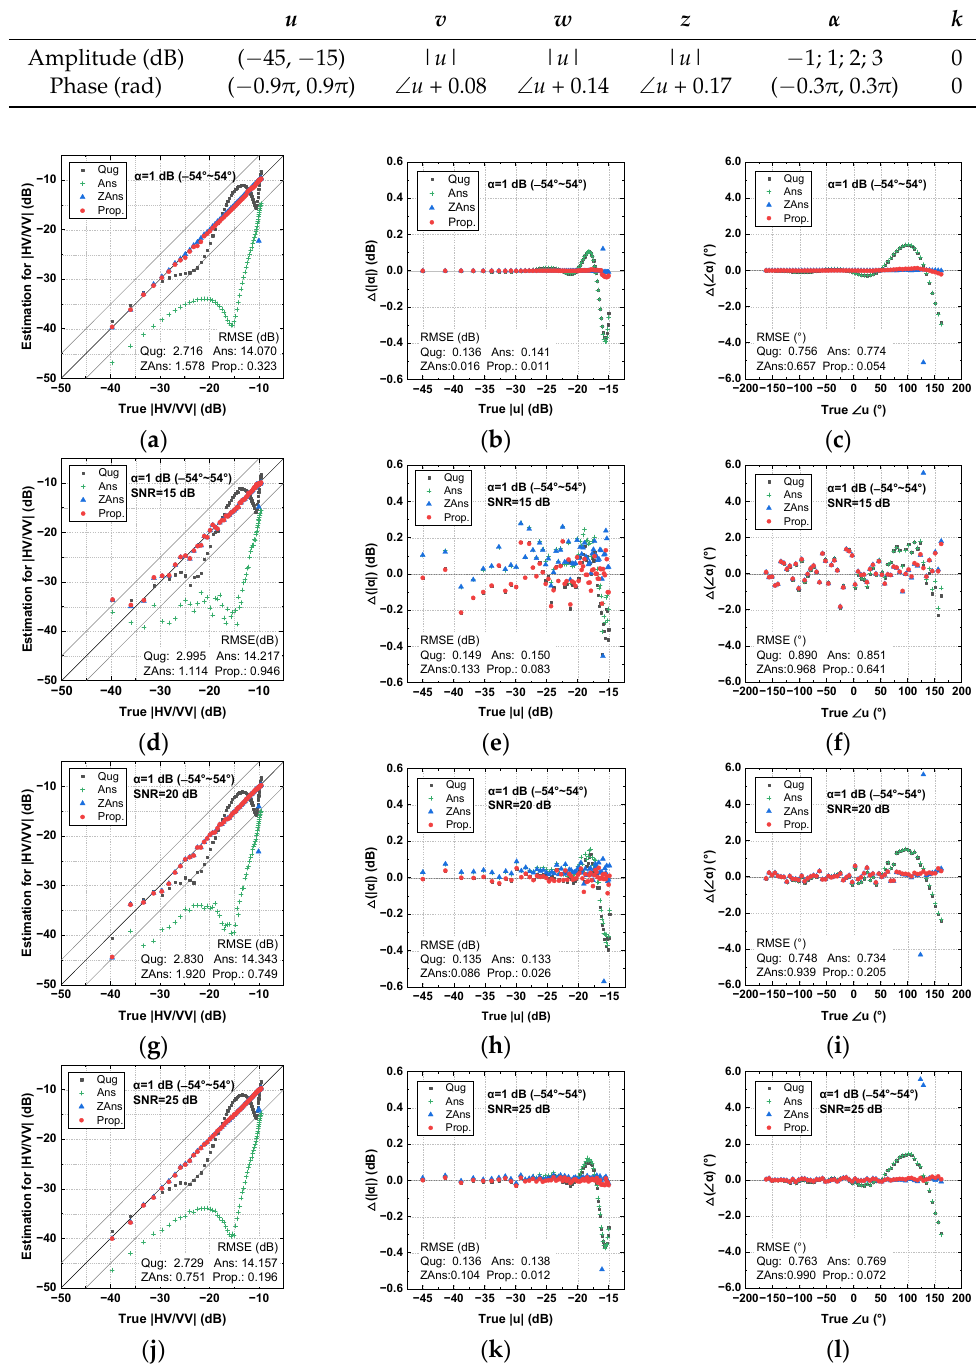
Table A1. The assumed amplitude and phase of distortions imposed on the simulated vegetation in order to validate the modified Quegan method.